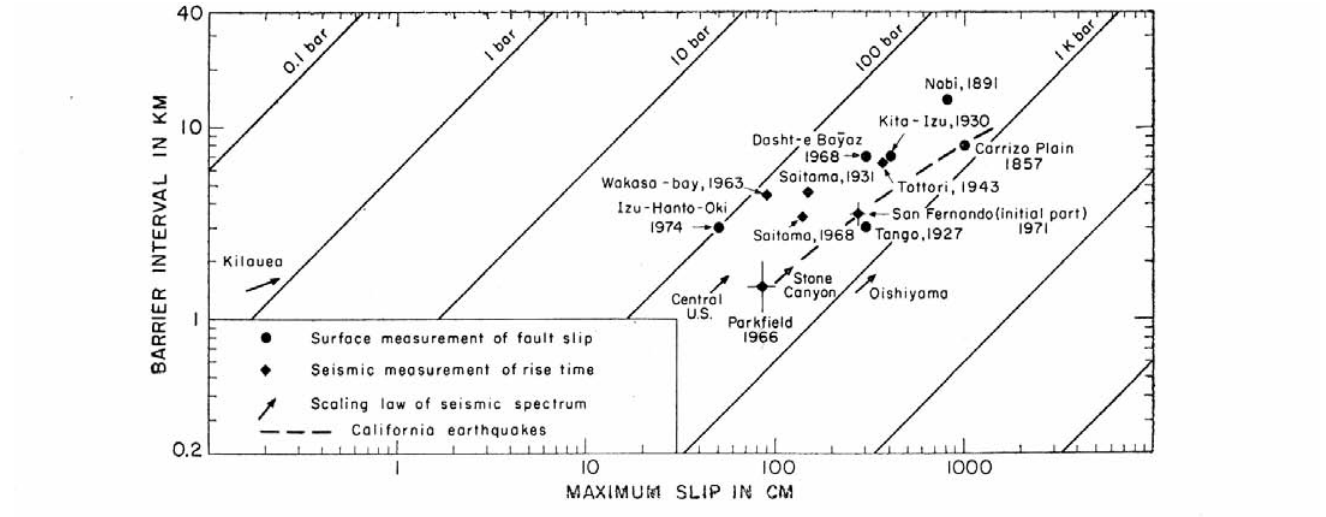
Figure 13. Relation between the barrier interval and the maximum slip obtained by various